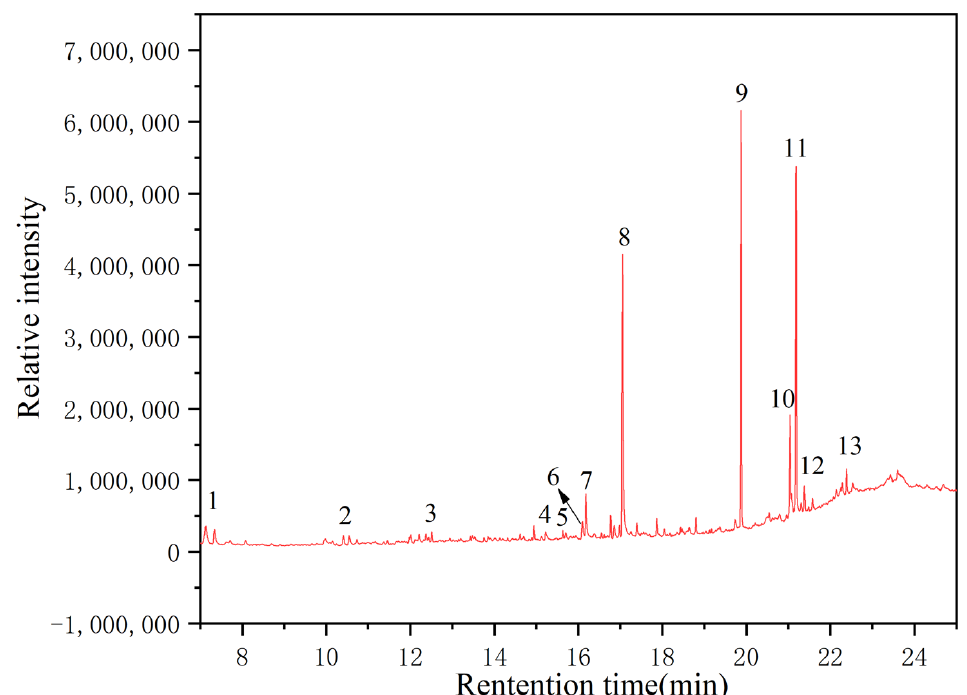
Figure 4. Total ion chromatography of mortar samples. Table 4. Composition of compound of mortar samples.